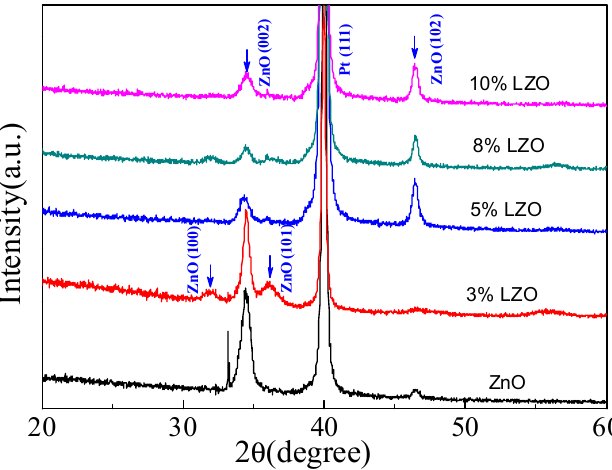
Figure 5. The XRD patterns of the LZO thin films under different Li doping concentrations.